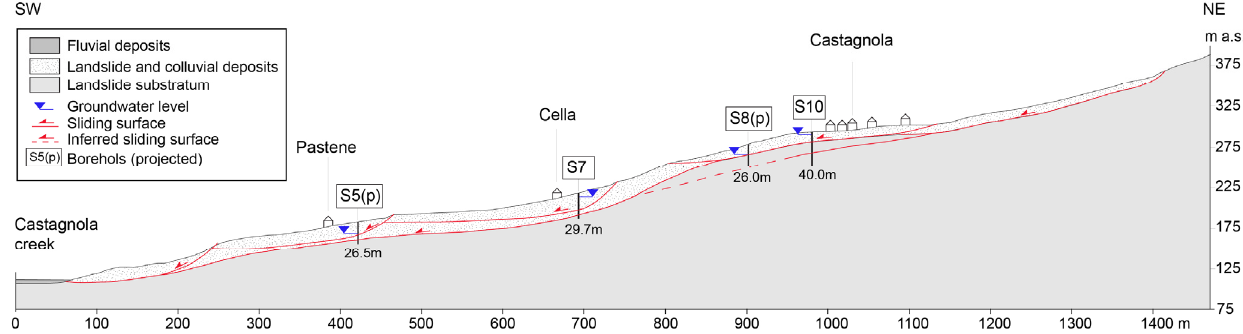
Figure 2. Landslide